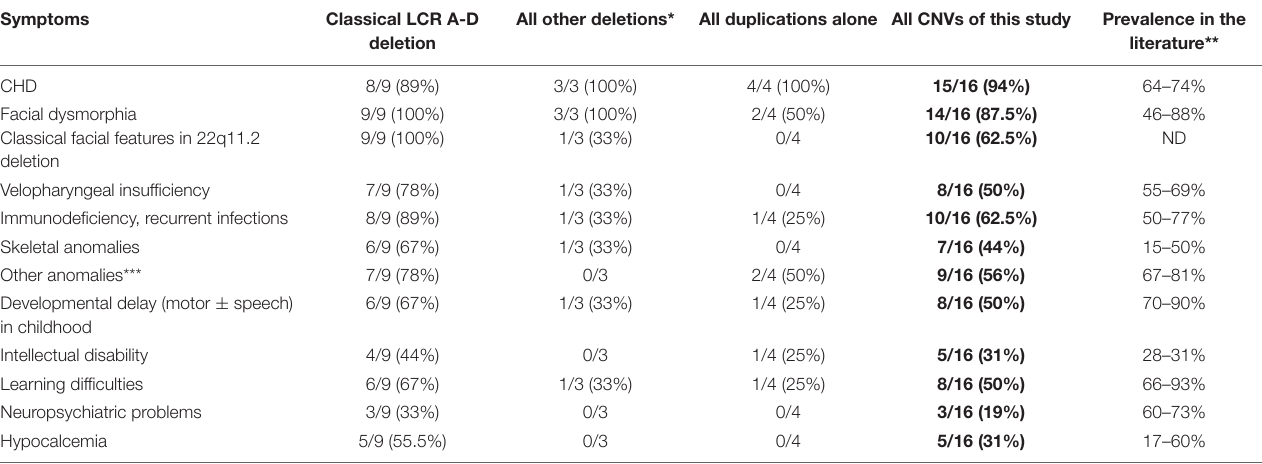
TABLE 4 | The prevalence of the common clinical features in all probands and family members carrying pathogenic CNVs and VUS in the 22q11.2 region compared to the prevalence in the literature. Symptoms Classical LCR A-D All other deletions* All duplications alone All CNVs of this deletion